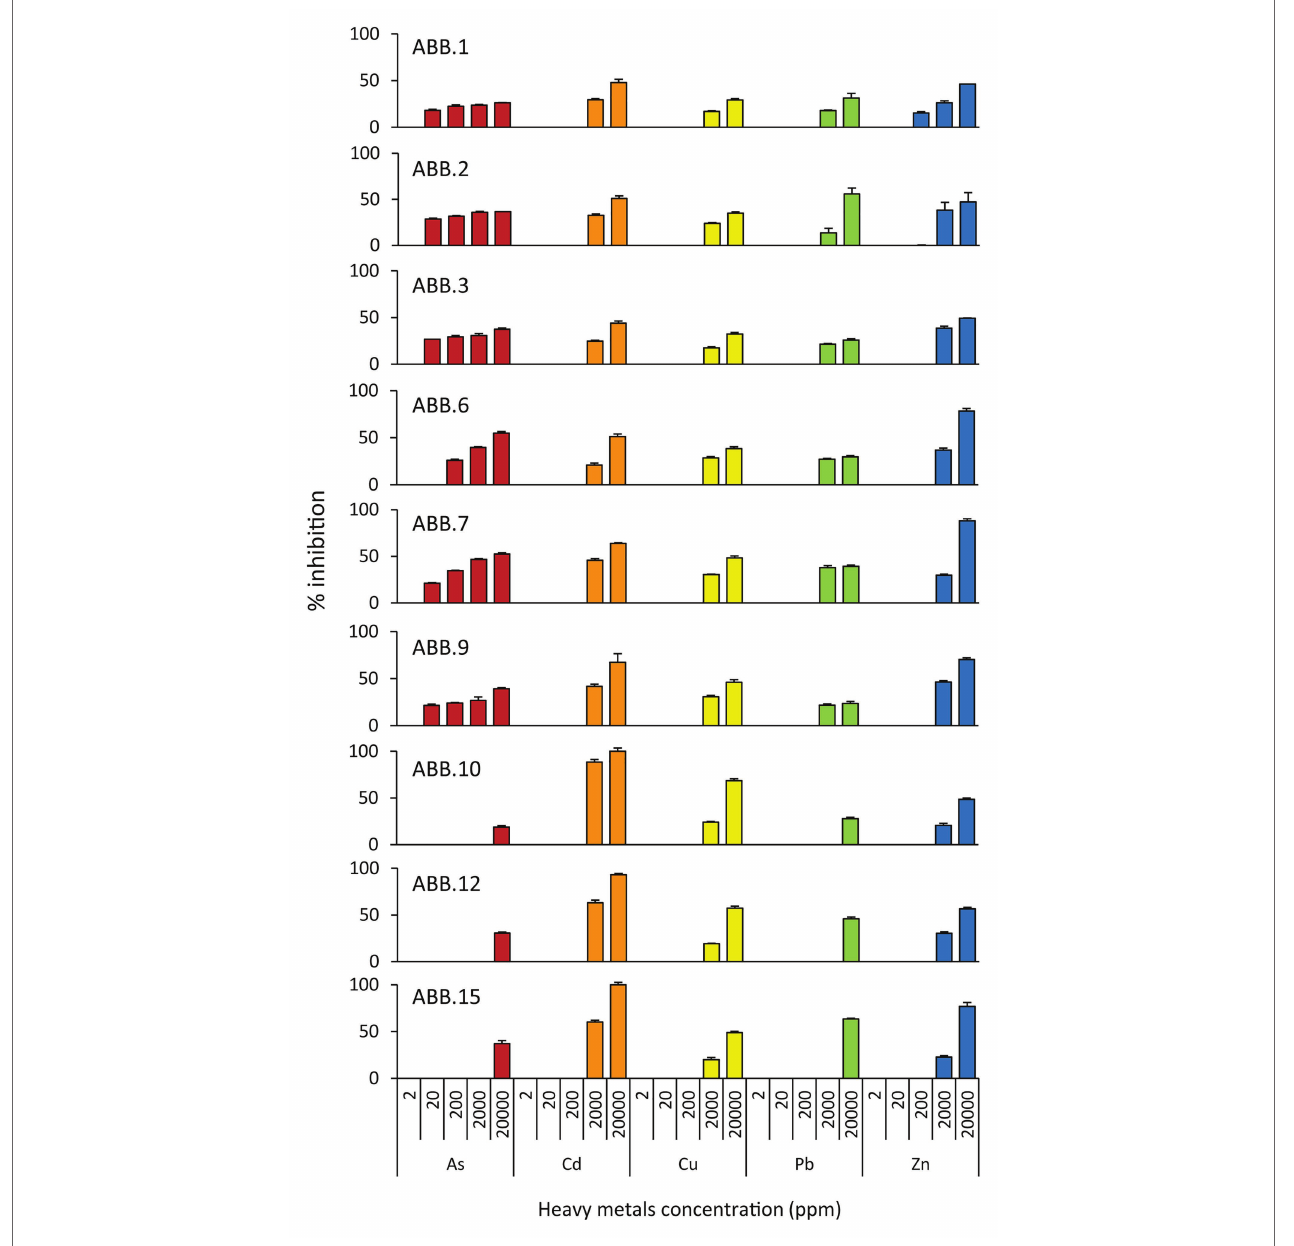
FIGURE 6 | Resistance of the isolated bacterial strains to heavy metals (HMs). Reported is the percentage of inhibition (from 0 to 100%) of the nine bacterial strains (ABB.1, 2, 3, 6, 7, 9, 10, 12, and 15) to the different HMs tested at different concentrations (from 0 to 20,000